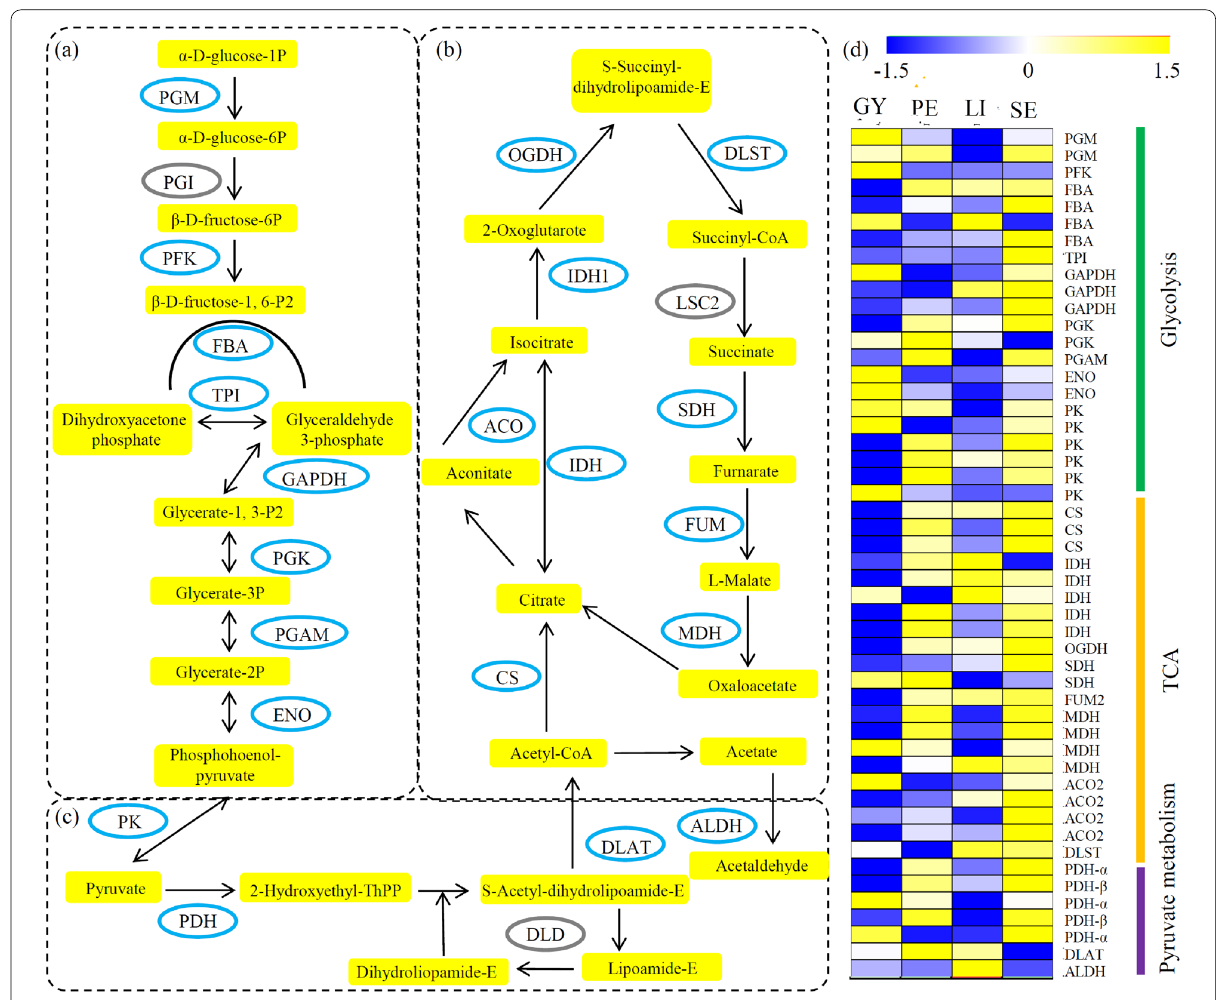
Fig. 5 Identification of energy metabolism-related proteins. a Identification of glycolysis-related proteins. b Differential expression of TCA cycle-related proteins among four different floral organs. c Differential expression of pyruvate metabolic pathway-related proteins among four different floral organs. d Differential expression of energy metabolism-related proteins among four different floral organs. The heatmap scale ranges from 1.5 to 1.5 −